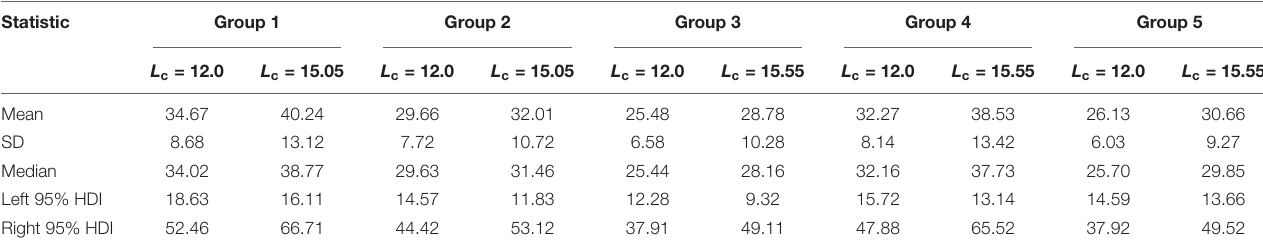
FIGURE 9 | Distribution of spawning stock biomass-per-recruit at F cur and at F MSY for each group of small yellow croakers when L c = 12.0 cm and L c = L cop . L copt was 15.05, 14.80, 15.15, 15.20, and 15.55 cm for Groups 1–5 when t max = 3, and 23.30, 22.67, 22.19, 22.76, and 22.35 cm when t max = t optmax . TABLE 3 | Summary of yield-per-recruit at the current fishing mortality rate for each group of small yellow croakers when t max = 3 years (unit: